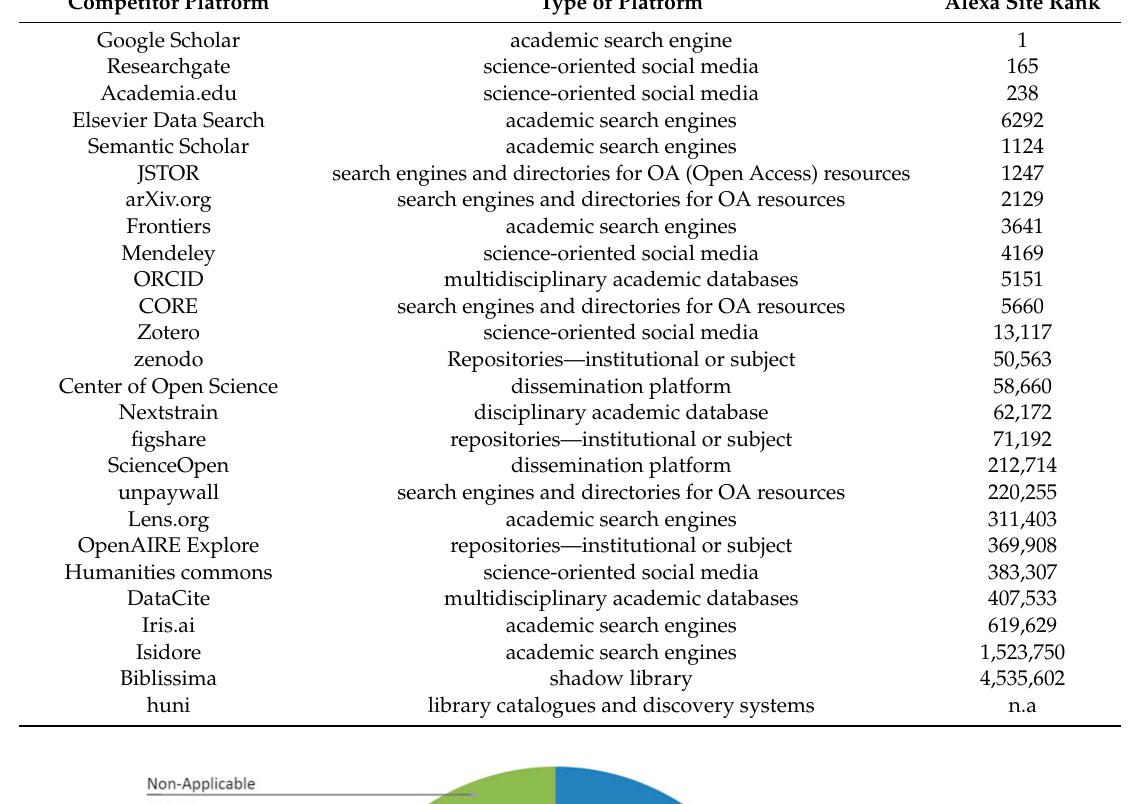
Table 1. Overview of analyzed platforms (Note: The Alexa site rank uses the root address of the platform, therefore the score for Google Scholar and Elsevier Data Search refer to Google and Elsevier).